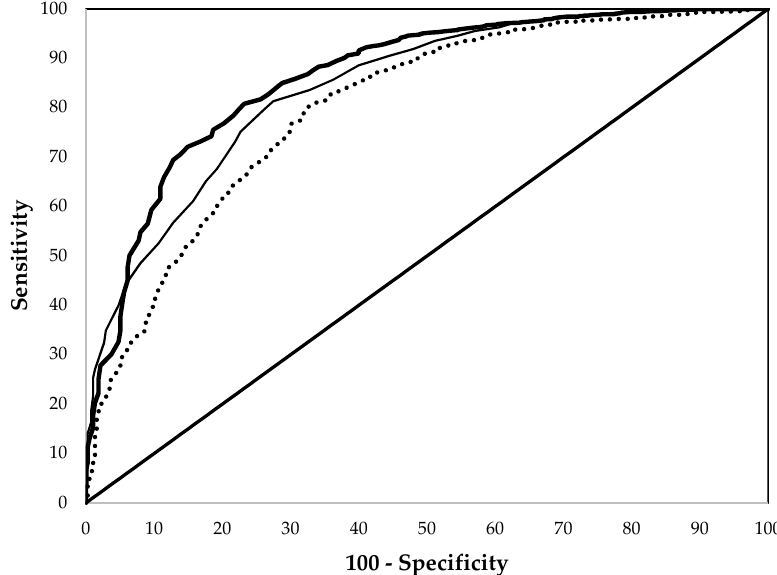
Figure 2. Comparison of the receiver operating characteristic curves of erythrocyte protoporphyrin (thick line), hemoglobin (thin line), and mean cell volume (dashed line) in detecting iron deficiency for non–pregnant women aged 15–49 years from the National Health and Nutrition Examination Surveys 2003–2006.